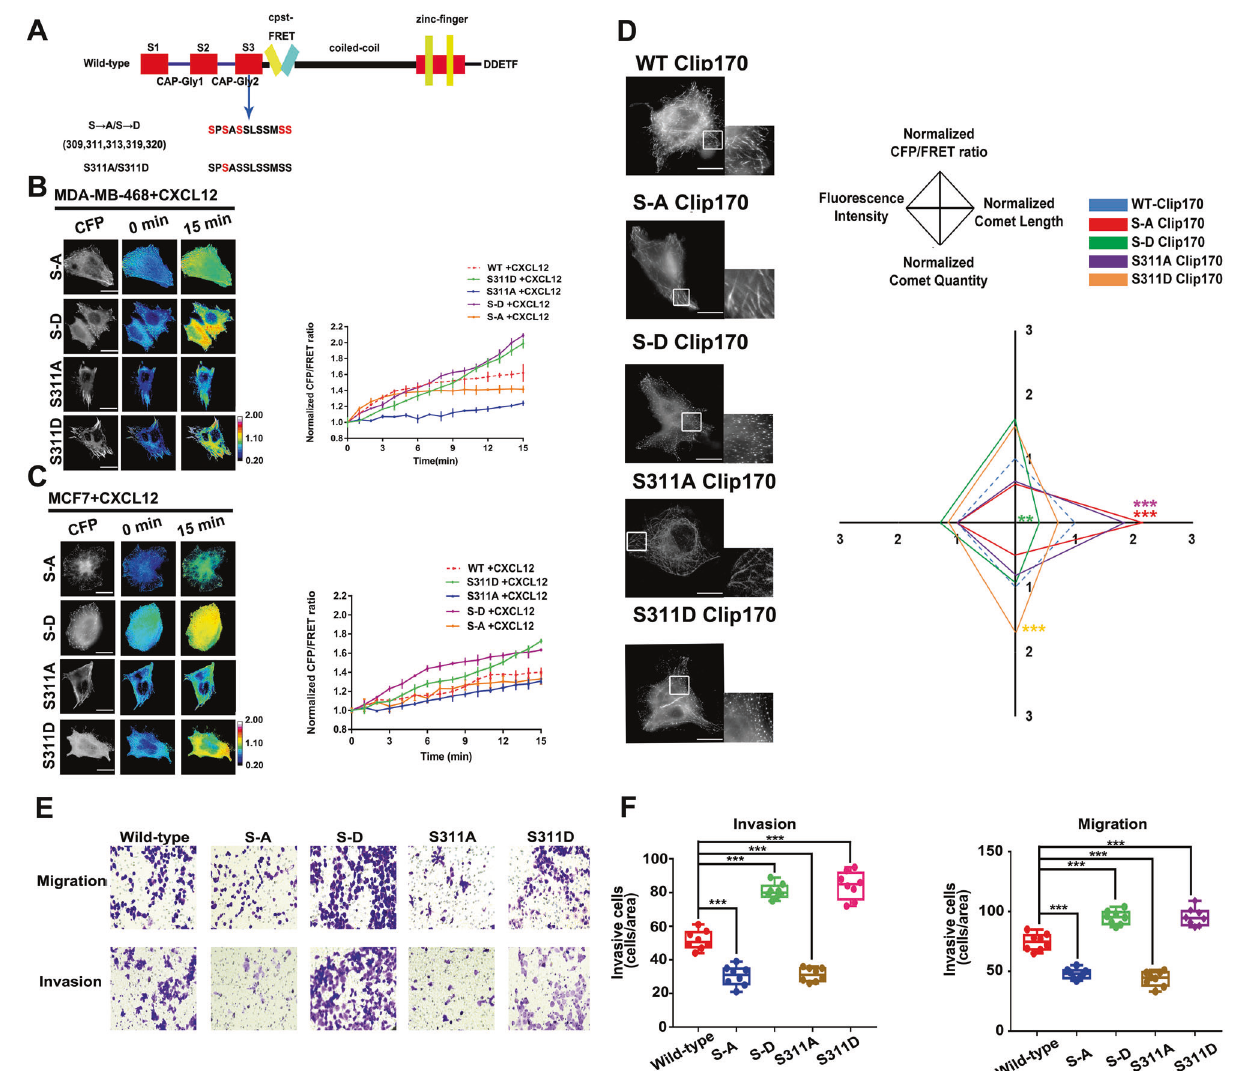
Fig. 4 Clip170 phosphorylation increases Clip170 tension and breast cancer invasion and migration. A The construction of the Clip170 mutation probes. B Left panel: 15-min time-lapse images MDA-MB-468 cells transfected with Clip170-S-D-cpstFRET, Clip170-S-A-cpstFRET, Clip170-S311D-cpstFRET or Clip170-S311A-cpstFRET probes after CXCL12 treatment. Calibration bar, 0.2 – 2.0; scale bar, 10 μ m. Right panel: Normalized CFP/FRET signals for the whole cell corresponding to Clip170 tension versus time (Mean ± SEM, n ≥ 6 cells in each group). C Left panel: 15-min time-lapse images MCF7 cells transfected with Clip170-S-D-cpstFRET, Clip170-S-A-cpstFRET, Clip170-S311D-cpstFRET or Clip170- S311A-cpstFRET probes after CXCL12 treatment. Calibration bar, 0.2 – 2.0; scale bar, 10 μ m. Right panel: Normalized CFP/FRET signals corresponding to Clip170 tension versus time (Mean ± SEM , n ≥ 6 cells). D Left panel: Representative images of MDA-MB-468 expressing Clip170-cpstFRET, Clip170-S311D-cpstFRET, Clip170-S311A-cpstFRET, Clip170-S-D-cpstFRET, and Clip170-S-A-cpstFRET probes. Right panel: Normalized CFP/FRET signals, comet lengths, comet quantities, and fl uorescence intensities for the whole cell in the different groups (scale bar, 10 μ m, n ≥ 6 cells in each group, ** P < 0.01, *** P < 0.001 compared with WT-Clip170 group). E Representative images of the migration and invasion of MDA-MB-468 cells in the WT, S311A, S311D, S-A, and S-D groups. F Quantitative analysis of the migration and invasion rates (Mean ± SEM, n = 3 independent experiments and at least three fi eld, *** P < 0.001 compared with WT-Clip170 group).